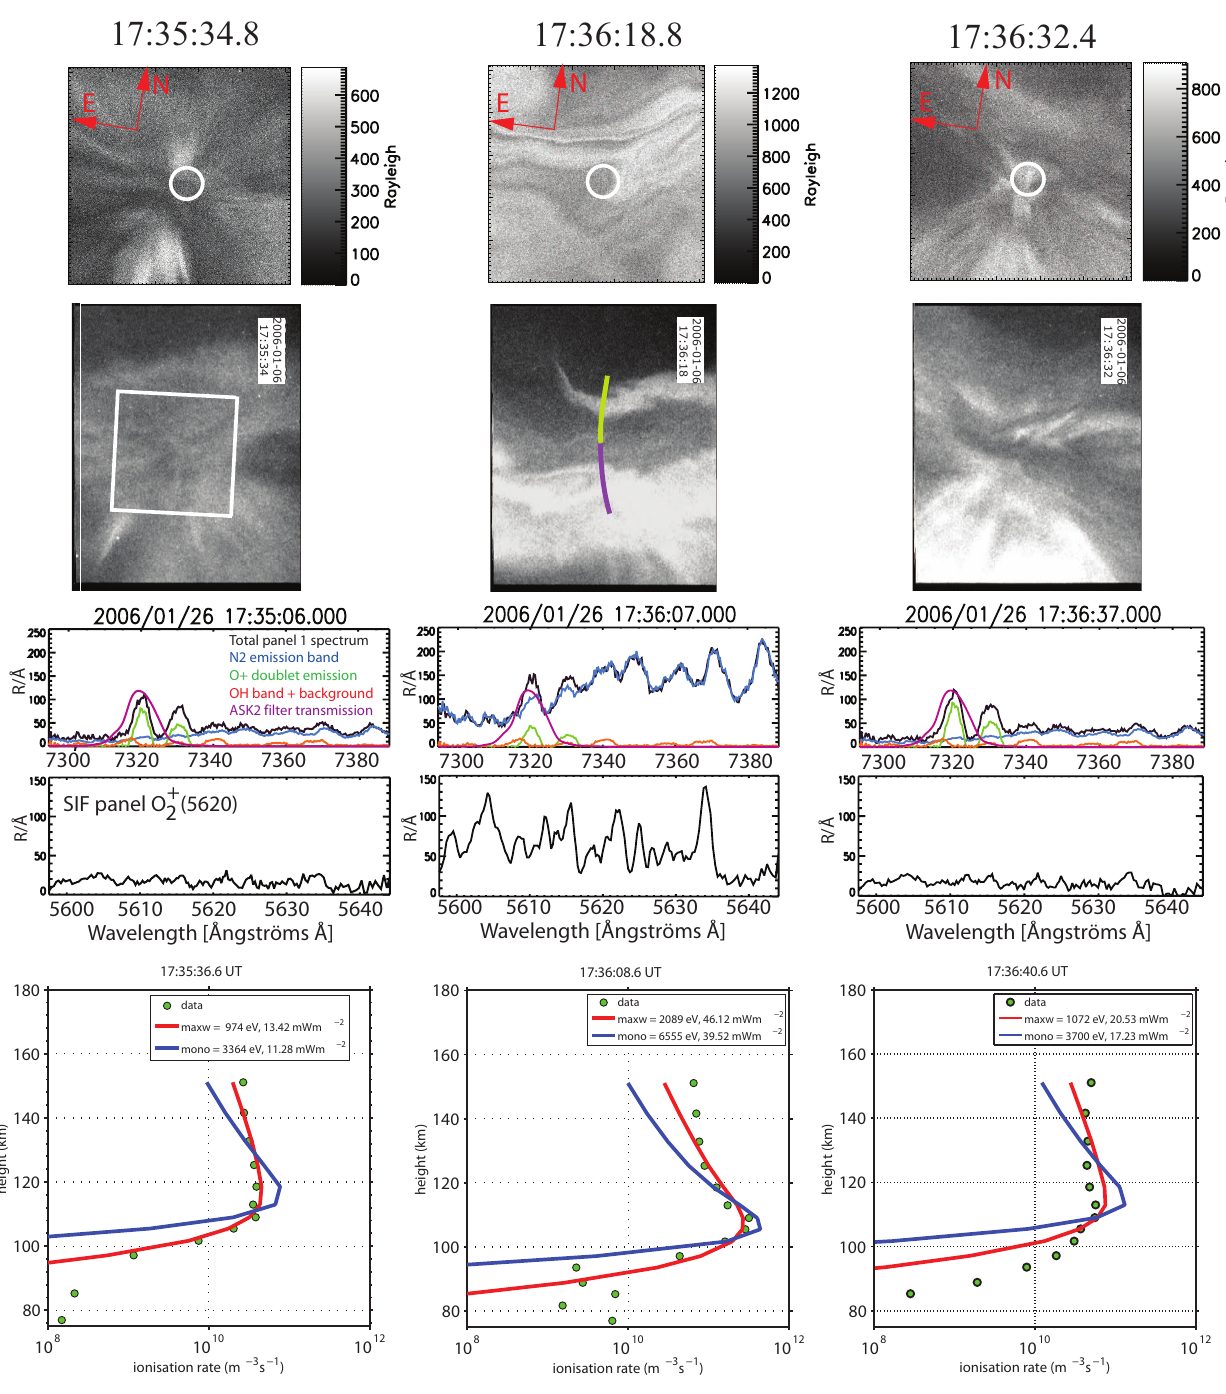
Fig. 4. Event 1: Optical and electron density data for three times from 17:35:00. The top row shows ASK3 images, the second row SIF video camera images, the third and fourth rows the SIF spectra. The bottom row are ionisation rate profiles derived from the ESR electron density profiles, and best fit model profiles with assumed Maxwellian and monoenergetic energy distributions. The ESR radar beam is indicated with circles in the ASK images. The ASK field of view is marked in the first SIF video camera image, and the HiTIES slit is marked in the second